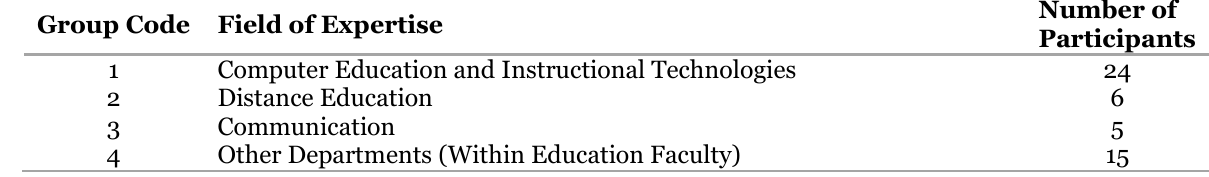
Participants and Their Fields of Expertise Group